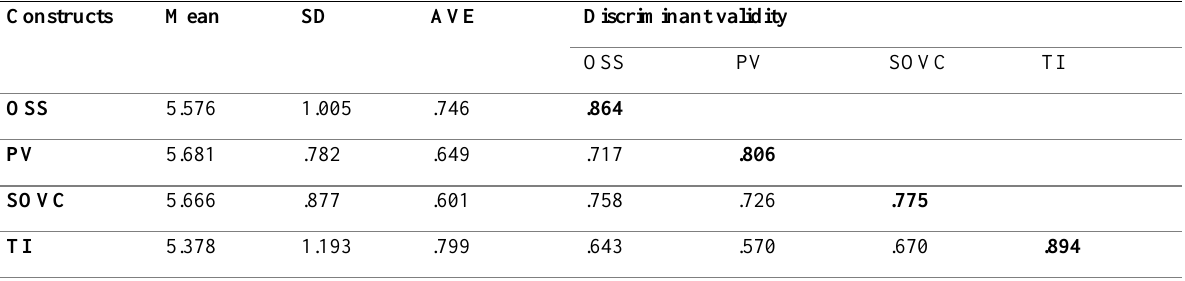
Table 3: Descriptive Statistics and Correlation of Study